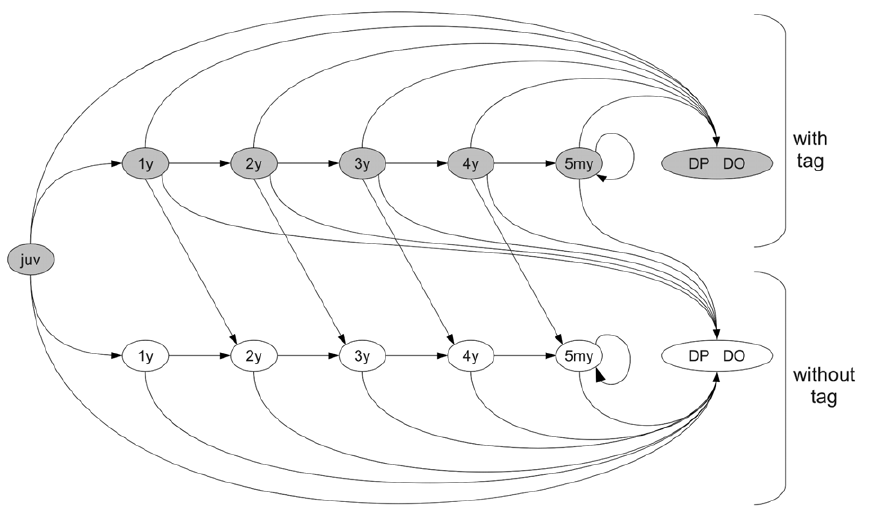
Figure 5. Diagram of possible states of a marked red kite. Transitions between two subsequent states, from time t to t z 1 , are denoted with arrows and correspond to parameters in the transition matrix of Fig. S1. For the sake of clarity, the parameters and the ‘‘unobserved dead’’ state are not reported. Notation: DP: dead by poison; DO: dead by other causes.